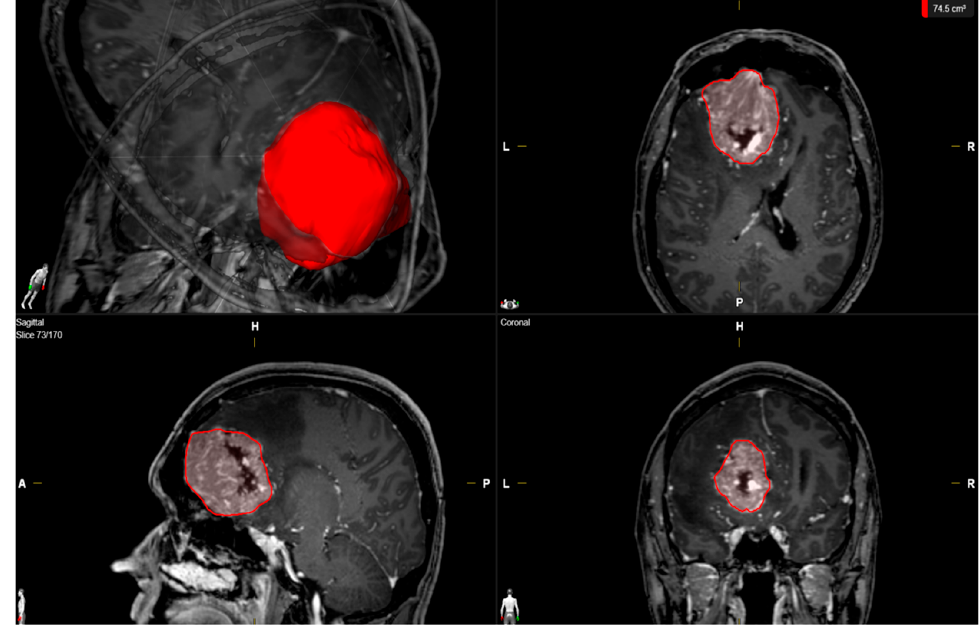
Figure 2. Illustrative measurements of the tumor volume (red) in a male patient with a left-sided falx meningioma using SmartBrush (Brainlab Elements, Brainlab AG, Feldkirchen, Bavaria, Ger-